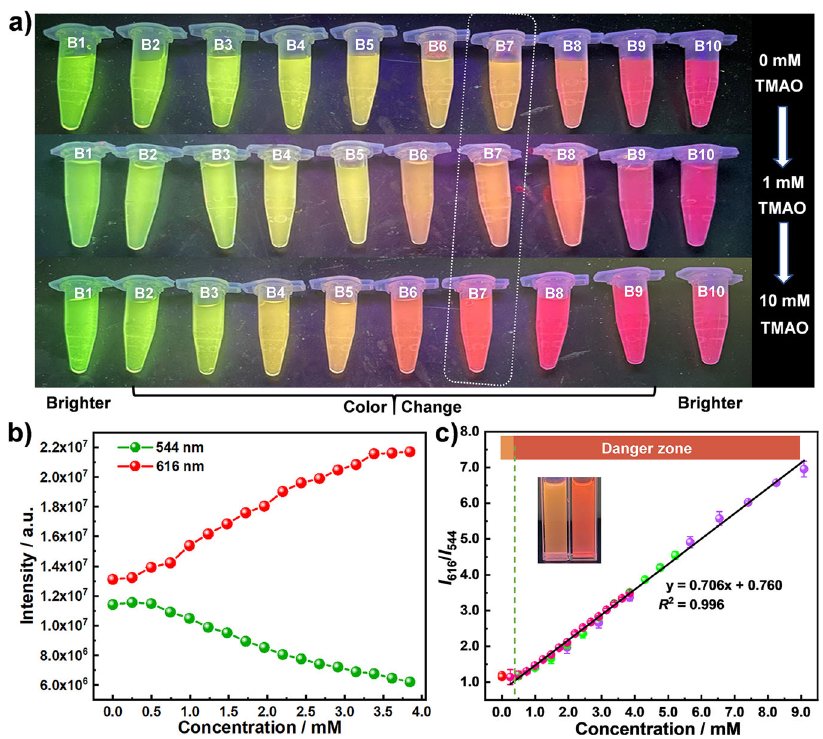
Fig. 2 Detection of TMAO. a Luminescent responses of B1 - B10 aqueous dispersions toward 1 mM and 10 mM TMAO under a 254 nm UV lamp. b Luminescent intensities of B7 at 544 and 616 nm with additions of TMAO. c Integrated luminescent intensities of B7 toward TMAO with different concentrations; green dotted line shows the critical TMAO concentration in infarcted patients and the inset shows photographs of B7 before and after adding 9 mM TMAO under 254 nm UV light. Error bar shows the data standard deviation of measured and theoretical